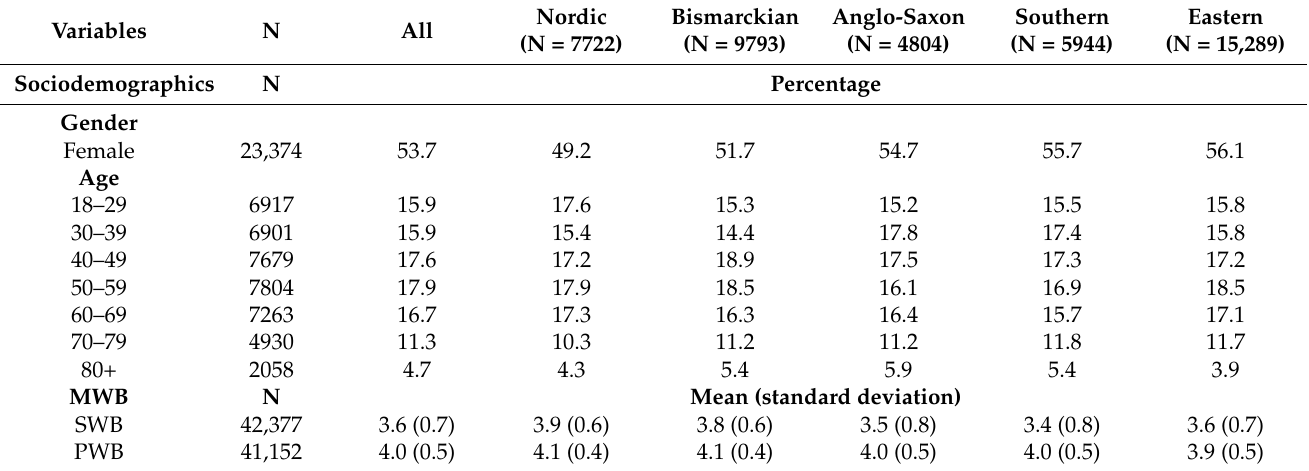
Table 1. Sociodemographic characteristics and mental wellbeing of the sample, by regime type. (N = 43,552).